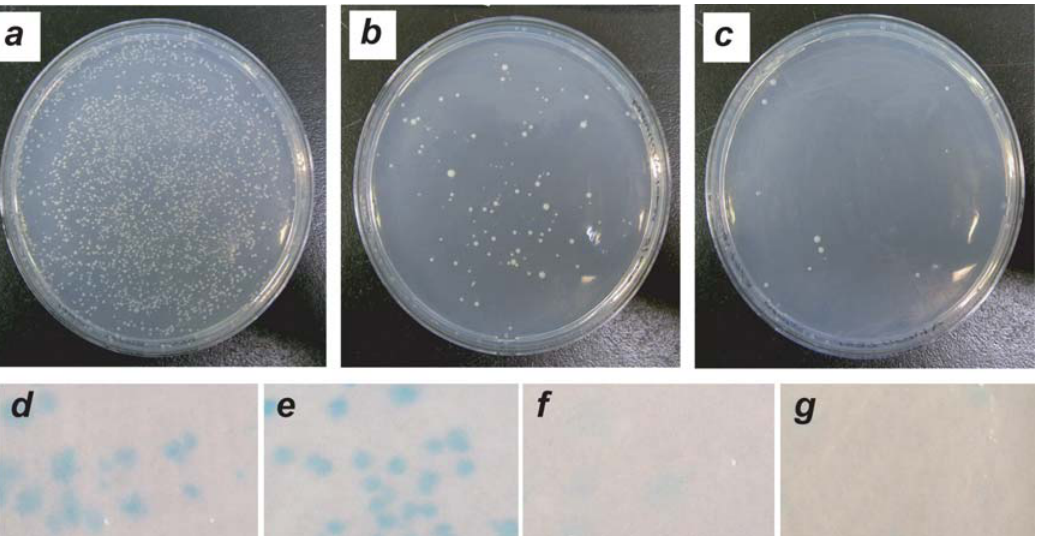
Figure 4. (top) The HIS3 assay. SD/-His/-Leu plates were incubated at 30 u C, six days. Note that bubbles arise from sorbitol in plate medium, and glare is visible in the lower right of each photo. a. Positive control Max bHLHZ on 20 mM 3-AT. b. ArntbHLH-C/EBP on 10 mM 3-AT. c. ArntbHLH-C/ EBP on 20 mM 3-AT. (bottom) Colony-lift filter assay. Note that intensity of blue color is affected by variations in colony size. Color intensity in photos is less vivid than actual plates. d. Positive control Max bHLHZ. e. ArntbHLH-C/EBP; positive binding (dark blue). f. ArntbHLH. g.